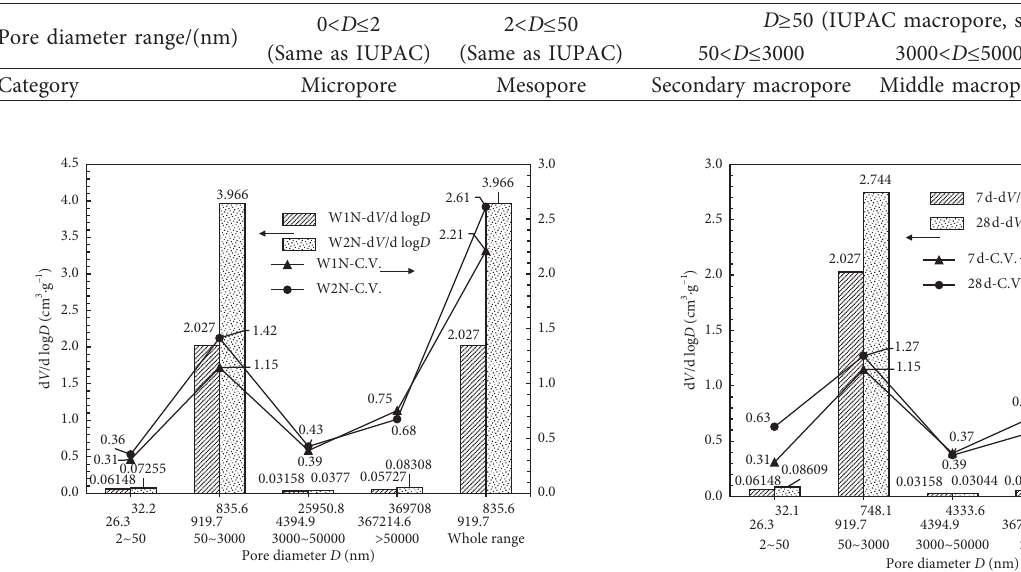
Figure 16: The d V /d log D of MPD and its C. V. in pore-diameter ranges of different-ages NCG concretion.